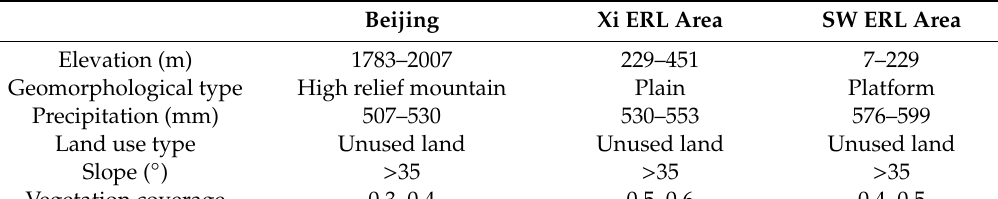
Table 6. High soil erosion risk in soil conservation ERL areas.